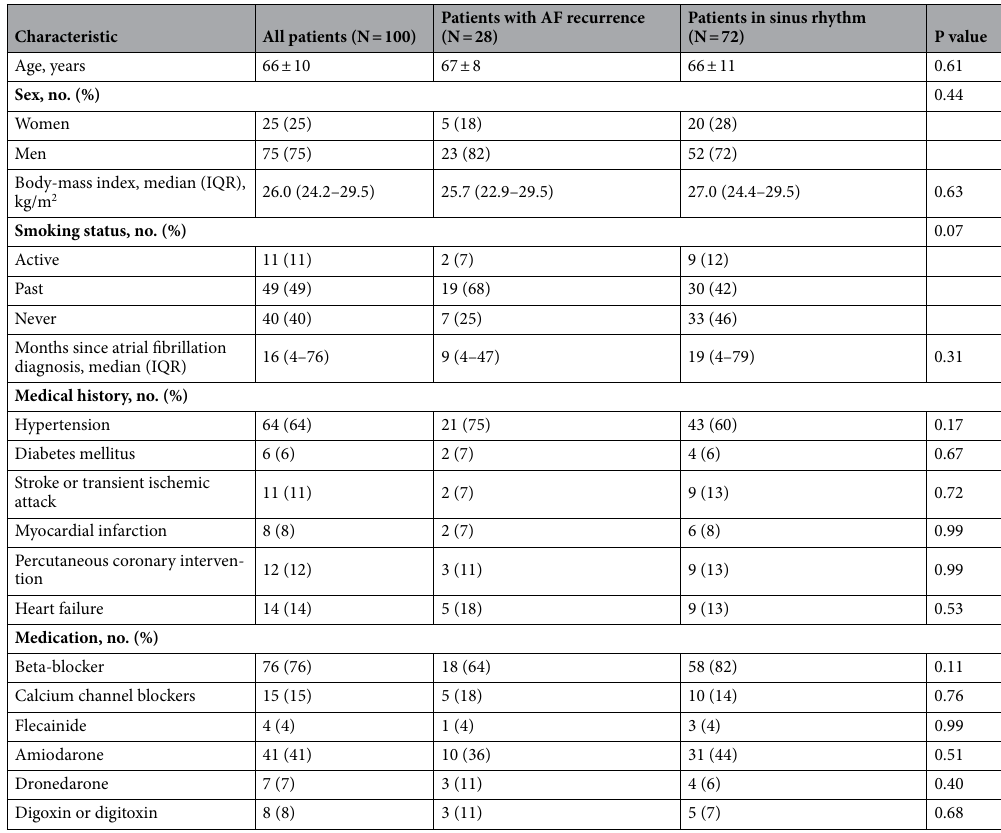
Table 1. Baseline characteristics of patients with and without AF recurrence after cardioversion. Values are means ± SD or median (IQR) and numbers (percent). P values compare patients between with AF recurrence and sinus rhythm and are obtained from Wilcoxon rank-sum tests for continuous variables and Fisher’s exact tests for categorical